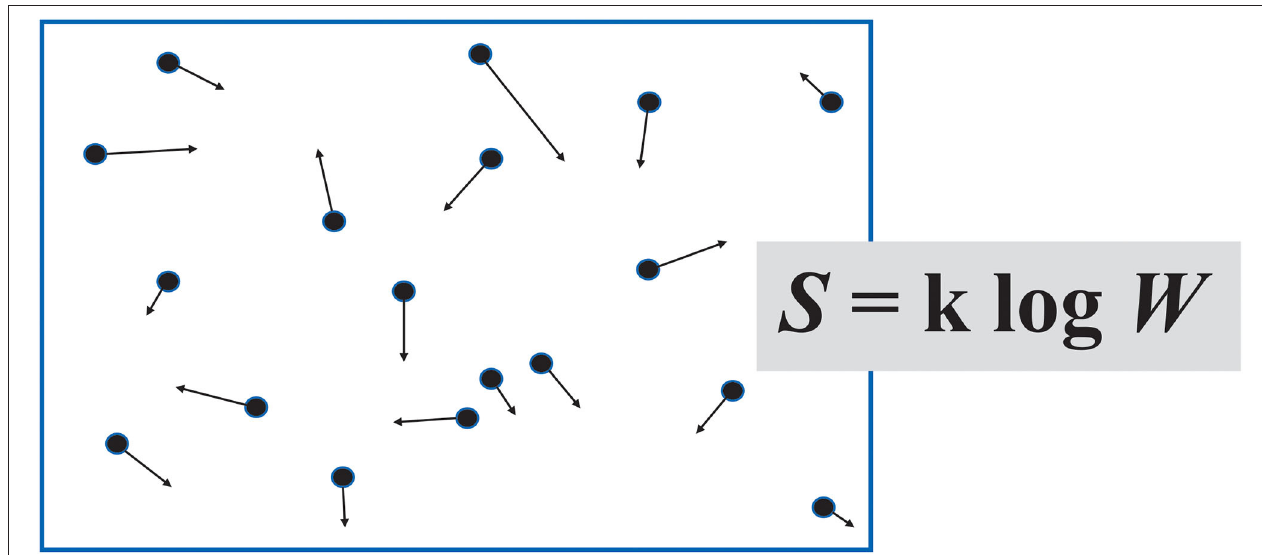
FIGURE 2 | Boltzmann imagined a container of gas as a set of “microstates,” based on the position and momentum of its individual molecules. In his formula for entropy S , W represents the number of microstates, were it possible to count